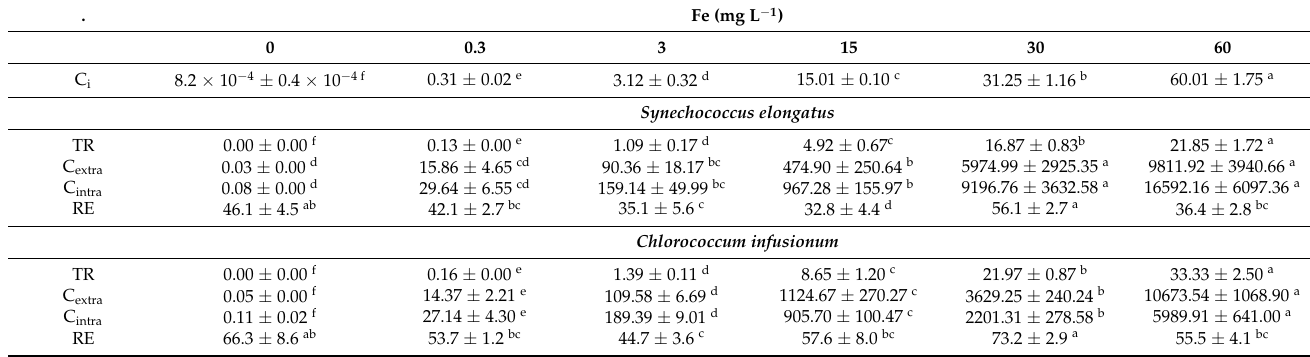
Table 1. Initial concentration in the media (C i , mg L − 1 ), total removal (TR, mg L − 1 ), extracellular concentration (C extra , ng 10 − 6 cells), intracellular concentration (C intra , ng 10 − 6 cells) and metal-removal efficiency (RE, %) in Synechococcus elongatus and Chlorococcum infusionum cells exposed to increased concentrations of Fe (mg L − 1 ) for 96 h. Data represent means of three replicates. Means ± SD of three replicates. Means followed by the same letter, in the line and within each metal and species, did not differ significantly ( p > 0.05) by the post hoc Tukey test. nd—not detected. . Fe (mg L − 1 )